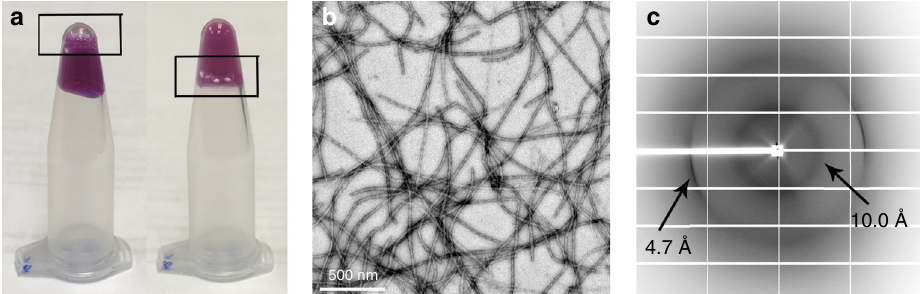
Fig. 1 mC-hnRNPA2-LCD forms a reversible hydrogel that contains amyloid-like fi brils displaying the cross- β diffraction pattern. a Left micro- centrifuge tube holds a homogenous solution of freshly puri fi ed mC-hnRNPA2-LCD. A bubble (box) rises to the top of the tube. The right tube contains the hydrogel formed by concentrated mC-hnRNPA2-LCD; the bubble is trapped by the hydrogel. b Hydrogel formed by mC-hnRNPA2-LCD visualized by transmission electron microscopy shows uniform, amyloid-like fi brils. Scale bar: 500 nm. c X-ray diffraction pattern of the hydrogel formed by mC- hnRNPA2-LCD. The two re fl ections characteristic of amyloid are visible at 4.7 and 10 Å spacings.